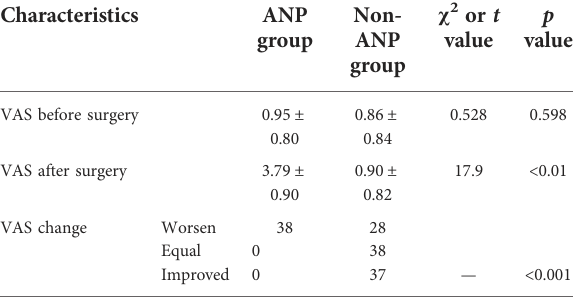
TABLE 3 Pre- and postoperative VAS and the change of VAS after surgery in two groups.